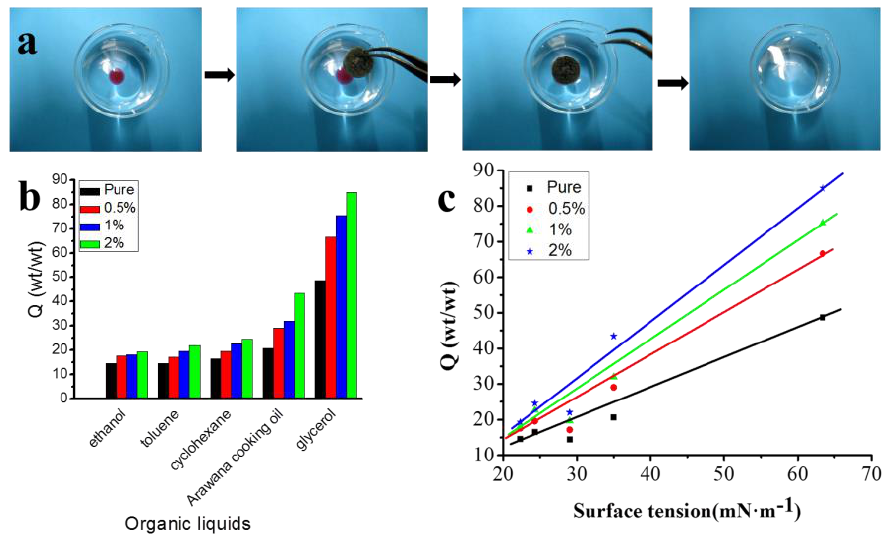
Figure 4. Oil absorption properties of the GIAs. ( a ) Snapshots of removal process of Arawana cooking oil (dyed with Oil Red O) floating on water. ( b ) Absorption efficiency of GIAs for various organic liquids and oils. ( c ) Absorption capacities of GIAs for organic liquids and oils as a function of surface tensions.